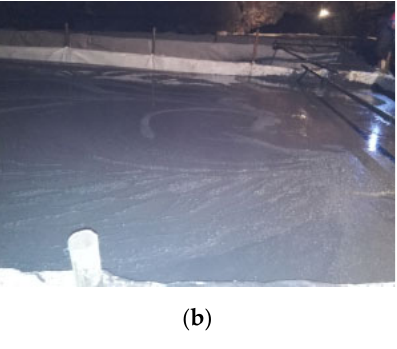
Figure 19. ( a ) Filling process; ( b ) Flow state. Figure 20. ( a ) Filter pipe arrangement; ( b ) Mining flow law in subsequent stope.